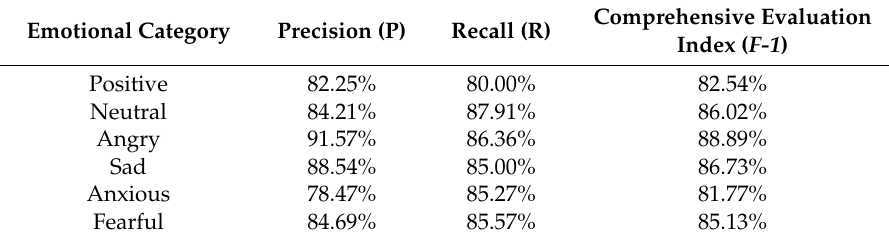
Table 2. Accuracy evaluation of positive emotion classification.